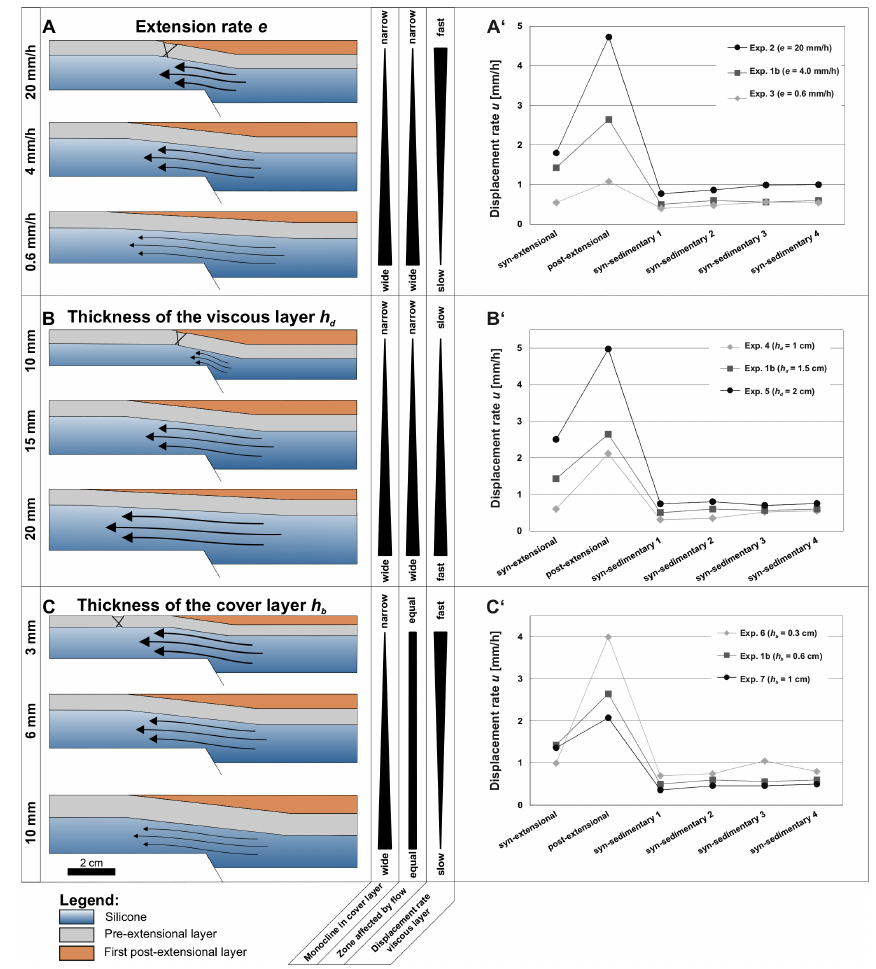
Figure 11. Summarized results of the structures, the kinematics, and the displacement rates u depending on (a/a’) extension rate at the basement fault e , (b/b’) thickness of the viscous layer h d , and (c/c’) thickness of the cover layer h b . Black arrows indicate extent of flow in the silicone layer, whereas the thickness of the arrows represents the displacement rates. Triangles and bars in the centre column reflect increasing or decreasing effect on structures and kinematics. The displacement rates are generally highest during the post-extensional phase. During the syn-sedimentary phases, the displacement rates are notably lower. Note that only the values of the first four syn-sedimentary phases are displayed while most experiments last